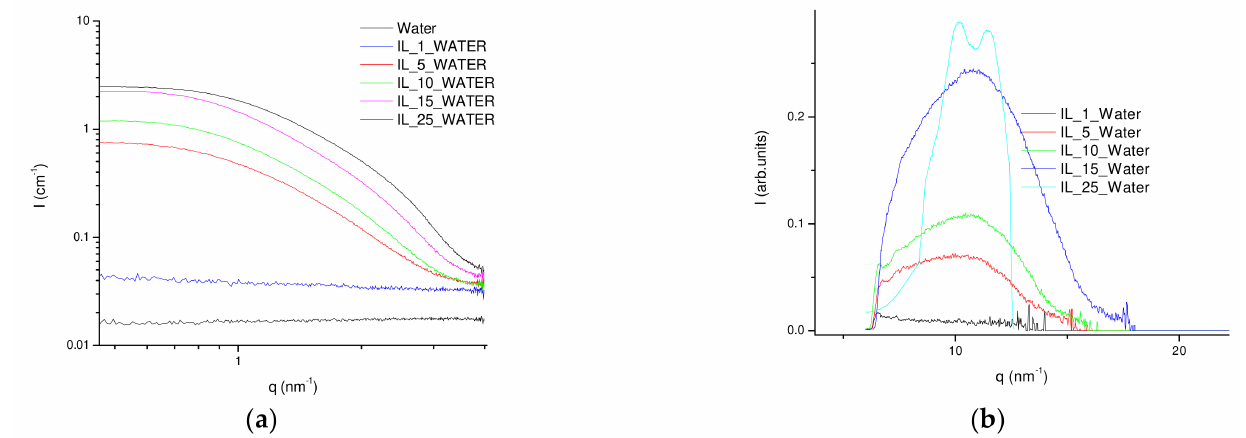
Figure 5. ( a ) SAXS and ( b ) WAXS profiles at room temperature (22 ◦ C) of ( — ) Water, ( — ) 1IL/Water, ( — ) 5IL/Water, ( — ) 10IL/Water, ( — ) 15IL/Water and ( — )